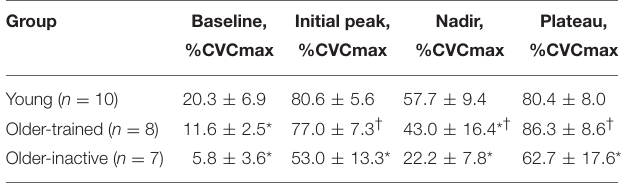
Values represent Mean ± 1 SD. CVC, cutaneous vascular conductance expressed as a percent of maximal (%CVCmax); * p < 0.05 different from young. † p < 0.05 different from old- inactive. The data for the young group were previously reported (Mack et al., 2016).